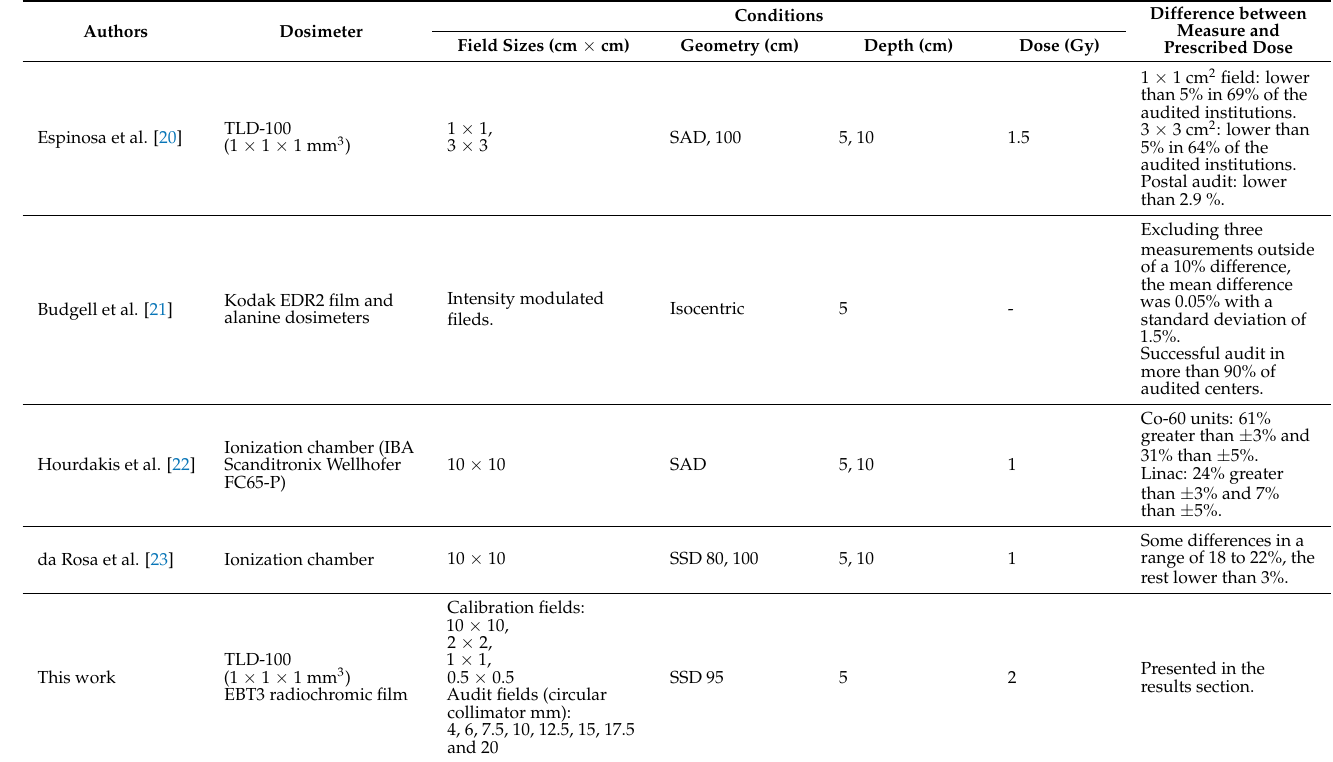
Table 1. Conditions under which dose measurement was carried out and the reported percentage differences between the measured and prescribed